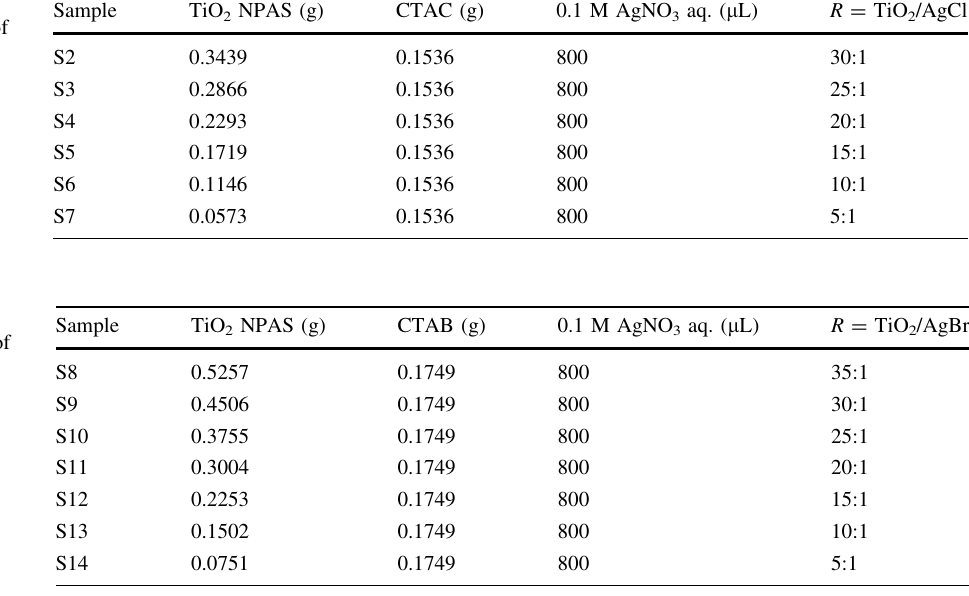
Table 1 Experimental condition for the preparation of different Ag–AgCl@TiO 2 NPAS samples